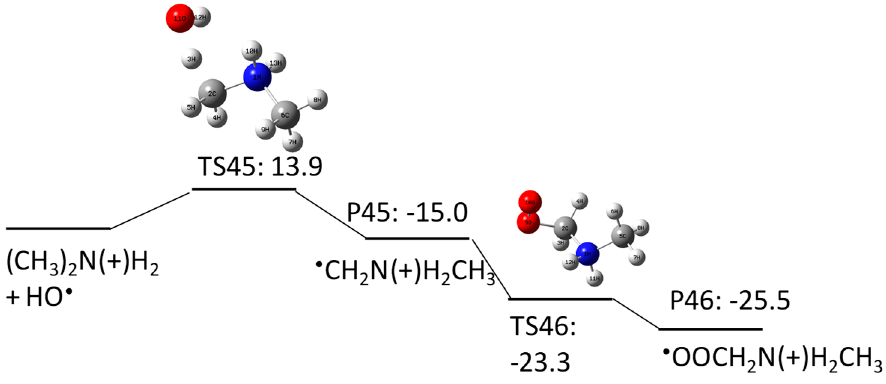
Figure 13. Free energy profile for pathway 4–2 of the HO • -induced reaction pathways for NDMA photolysis. NDMA